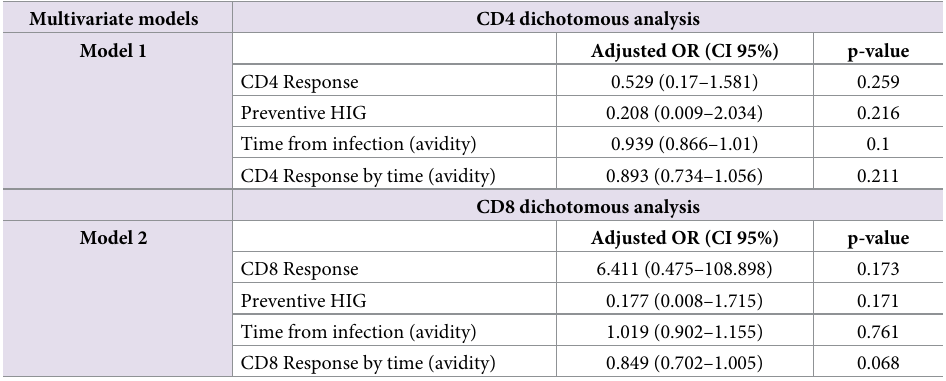
Table 3. Multivariate models of T-cell immune response.